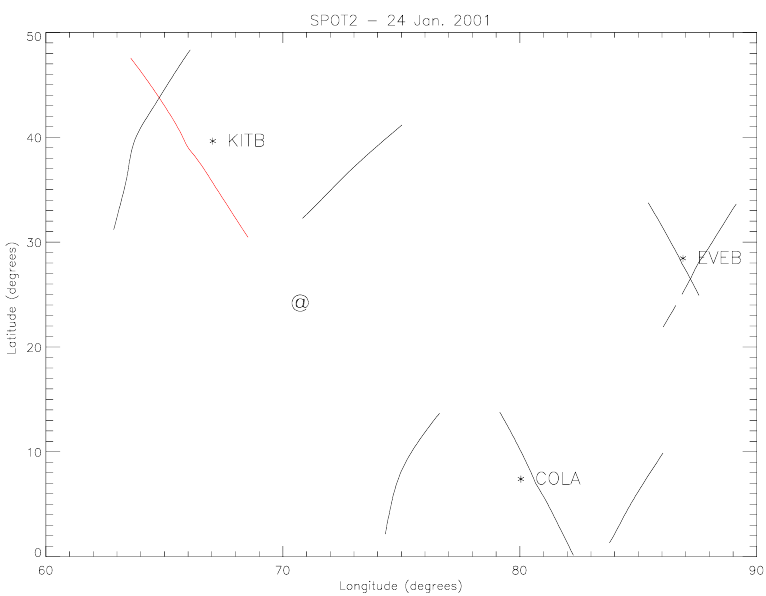
Fig. 2. Positions of the SPOT2 subionospheric points around three different DORIS stations during 24 January